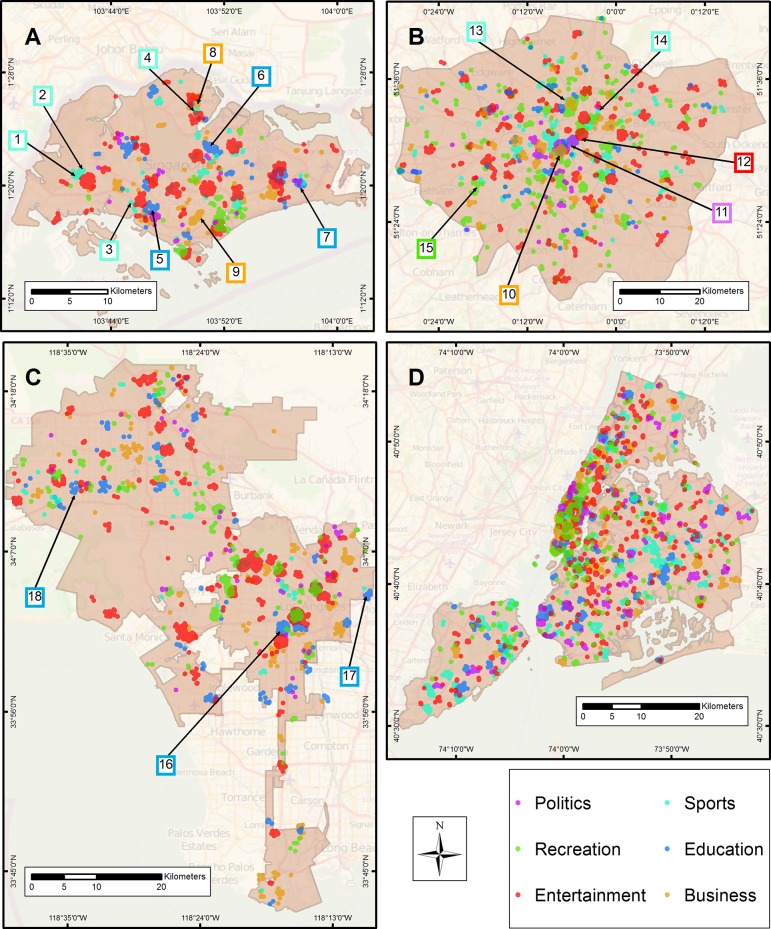
Maps depict significant hotspots for each of the high-level categories for (A) Singapore, (B) London, (C) Los Angeles, and (D) New York City. Additionally, the maps are annotated with sample locations were the hotspot aligns with a place with common meaning such as a school or stadium. The outlines of the numbered boxes correspond to the map legend colours. In map (A) Singapore, 1) Jurong West Stadium 2) Golazo Futsal Singapore 3) Clementi Stadium 4) Yishun Stadium 5) United World College of South East Asia 6) Nanyang Polytechnic 7) Temasek Polytechnic 8) Yishun District and 9) Orchard Road. In map (B) London, 10–12) West End of London 13) Emirates Stadium 14) Olympic Stadium and 15) Richmond Park. In map (C) Los Angeles, 16) University of Southern California 17) California State University Los Angeles and 18) California Lutheran University.